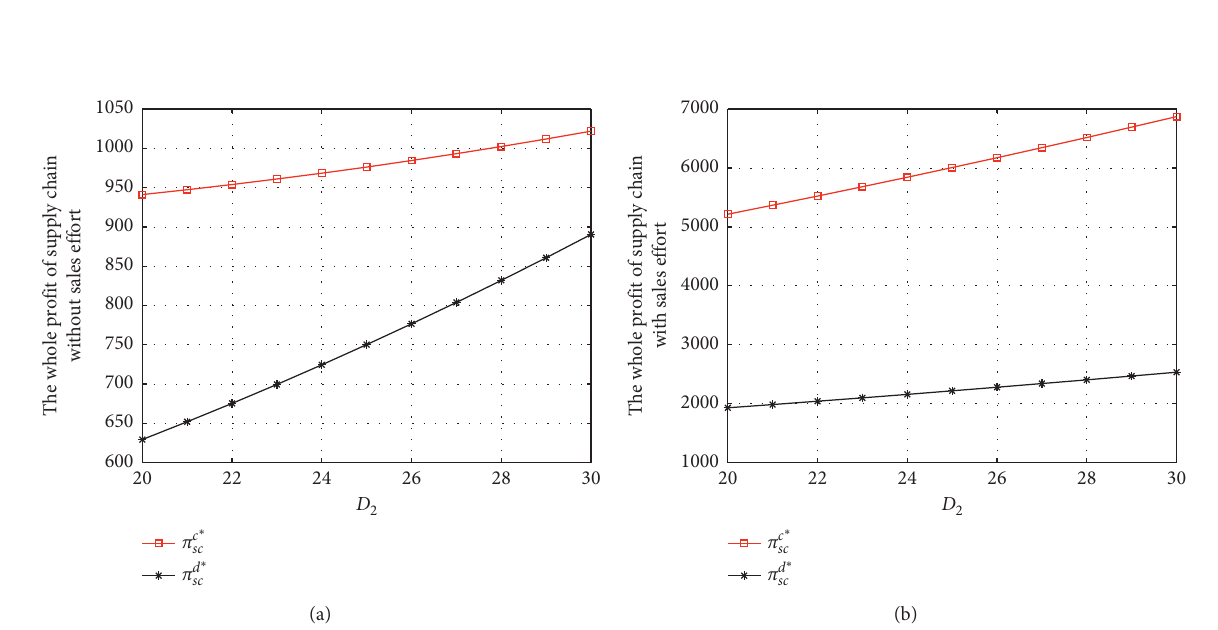
Figure 2: The optimal profit of whole supply chain under the centralized and decentralized model.